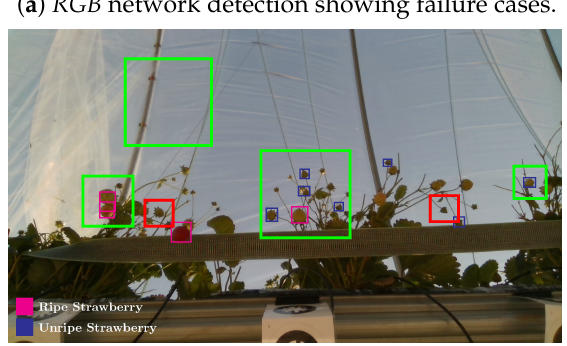
Table 5. The evaluation metrics used are in correspondence with the original paper (IoU at 0.4) and only classification scores greater than 0.9 are considered. The images contained in the sweet pepper data set were not as high resolution as with our Strawberry data set described in Table 2 but instead